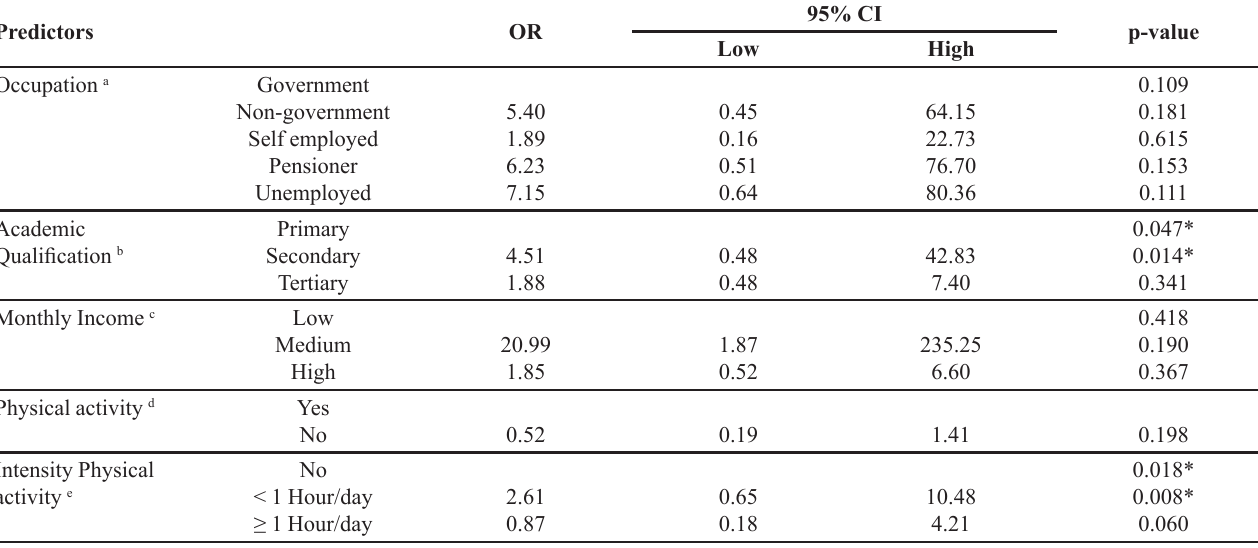
TABLE V - Predictors of Asymmetric Dimethylarginine (ADMA) level (Binary Logistic Regression – Factors Associated with ADMA